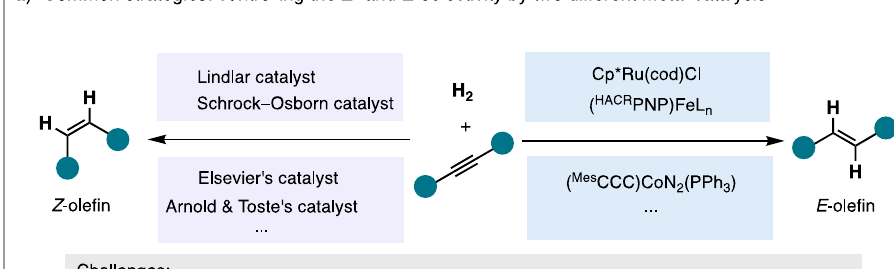
Fig. 1 | Controlling the stereochemistry in alkyne hydrogenation for highly selective formation of E - and Z -ole fi ns. a Commonly used strategy in the control of the E - and Z -selectivity by two different metal catalysis. b Controlling the E - and